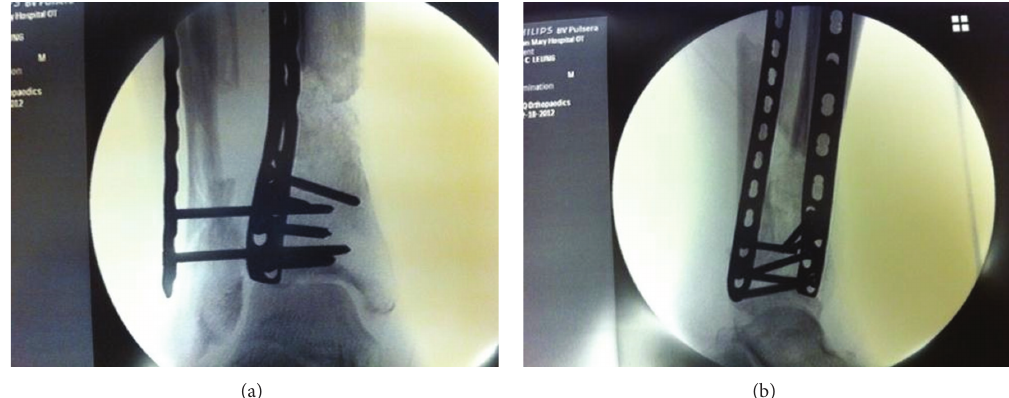
Figure 3: AP (a) and lateral (b) fluoroscopic images showed the cement spacer being removed and the defect filled with cancellous autograft harvested from iliac crest.